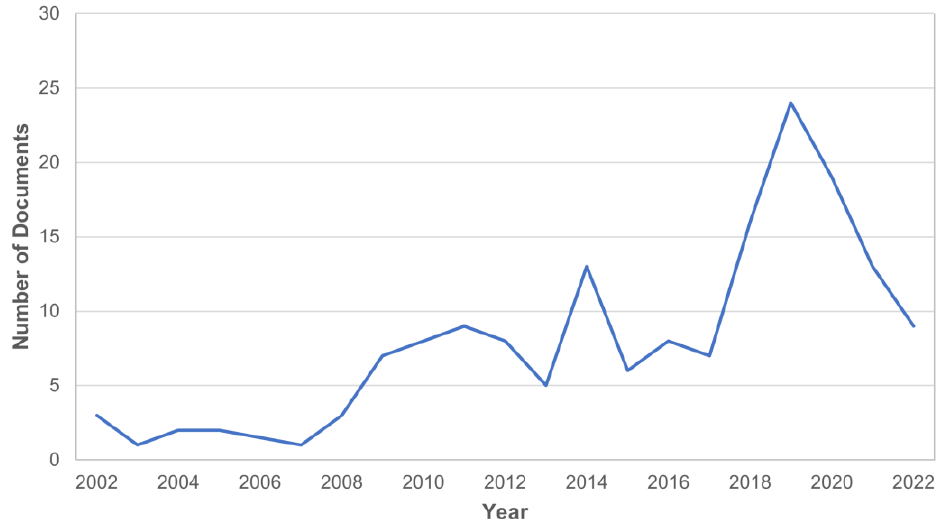
Figure 3. Number of publications per year on EAOPs using diamond technology for water treatment, based on the Scopus database (source: the authors).